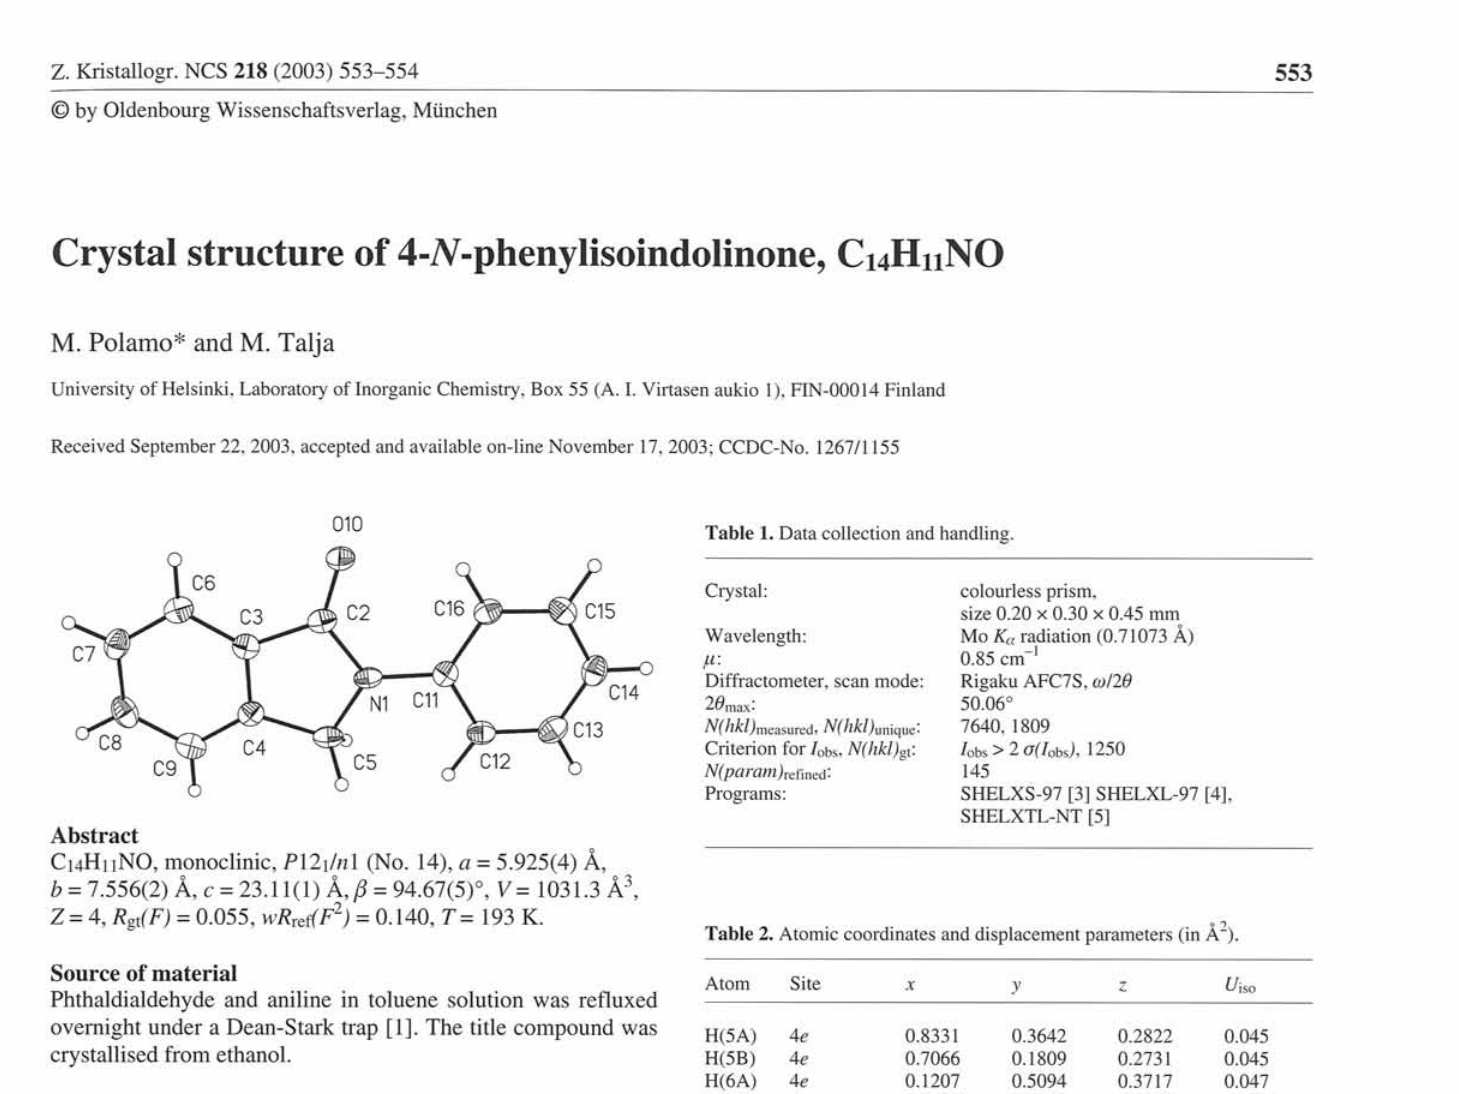
Table 2. Atomic coordinates and displacement parameters (in Á^).